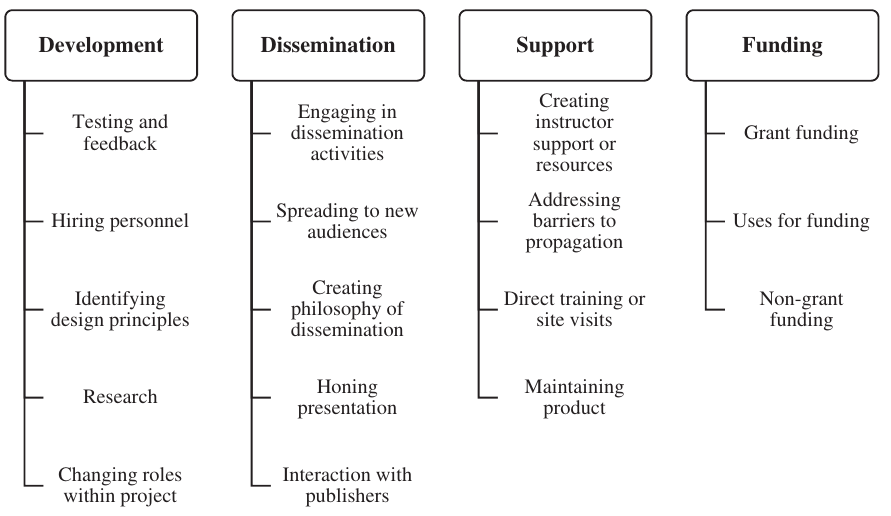
FIG. 4. Overview of coding system hierarchy, with the four main categories on top and frequently mentioned codes associated with each